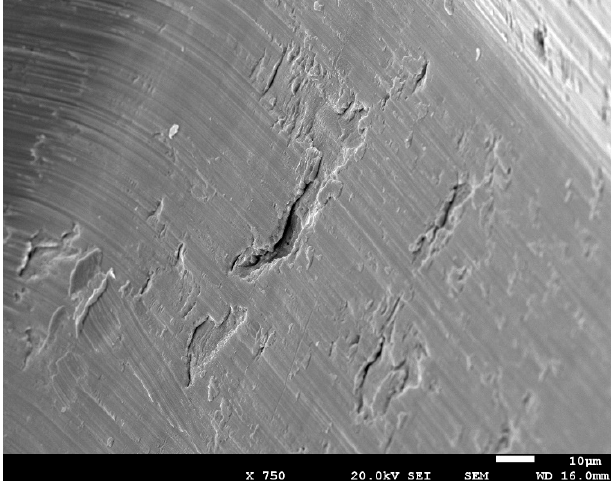
Figure 4. Crack nucleation in the connection place (dental implants with the abutment). In this zone, the mechanical load was the highest and the width of the dental implant was the lowest.